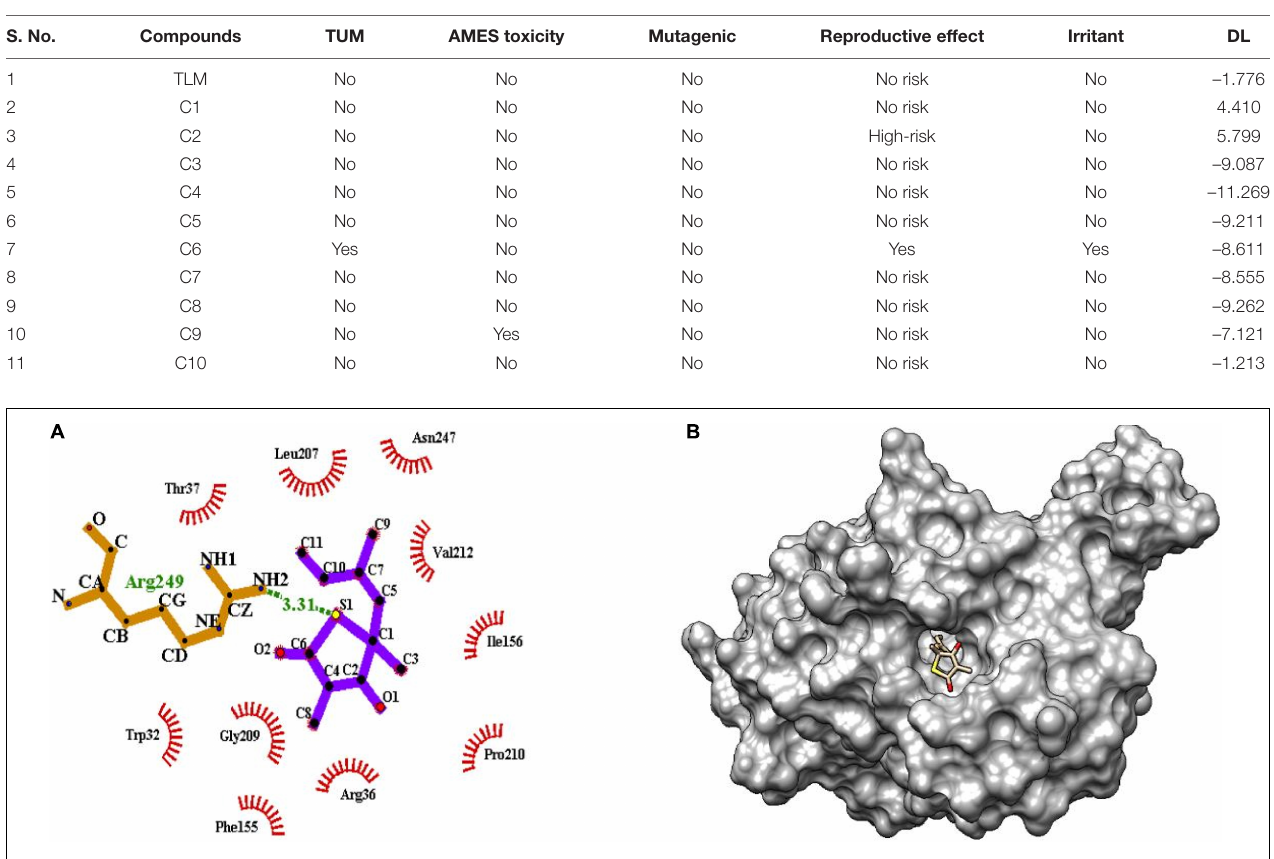
FIGURE 5 | (A) Molecular interaction of inhibitor TLM at the active site of mtFabH using LigPlot. (B) Surface view of mtFabH-TLM complex using Schrodinger.